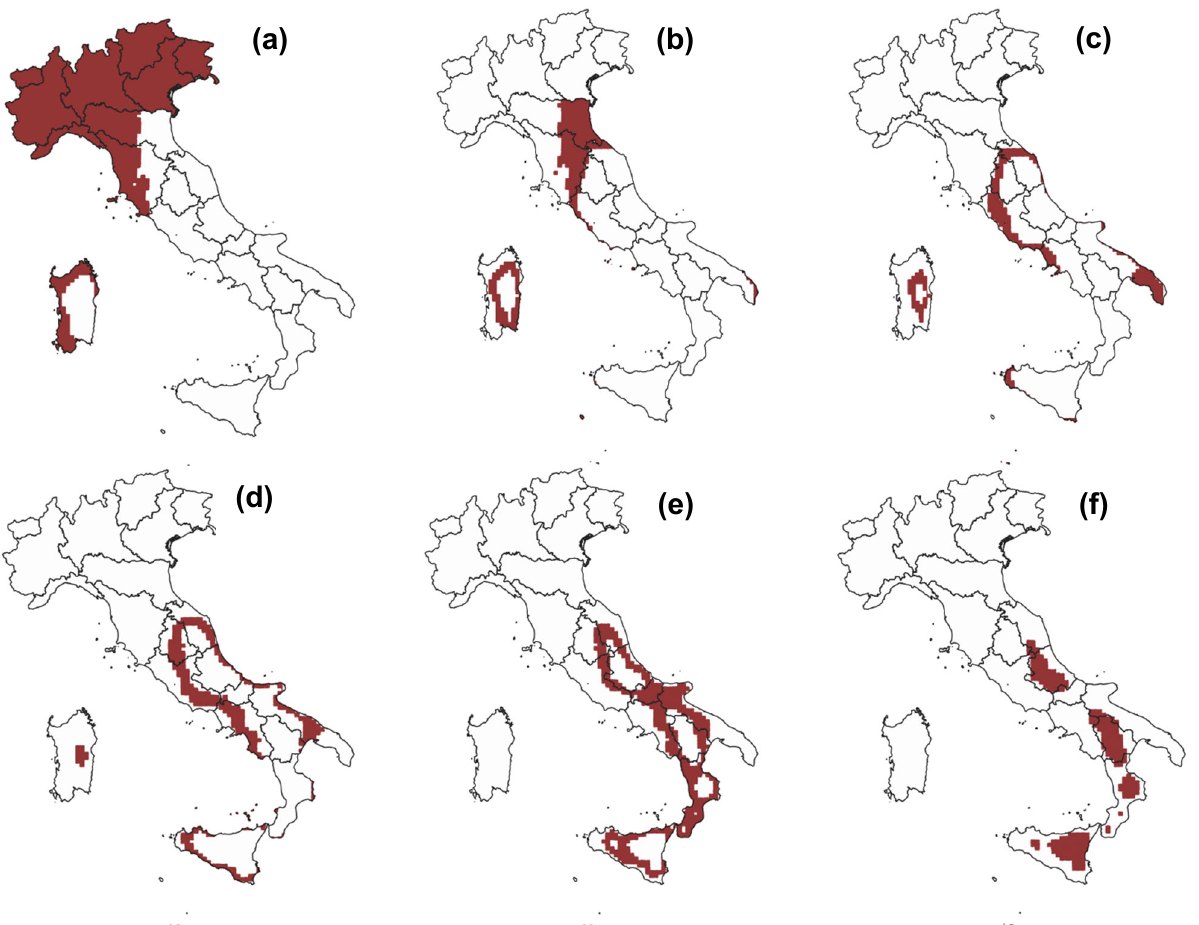
Figure A1. Location of Italy and the Italian macro-regions considered for exposure evaluation.